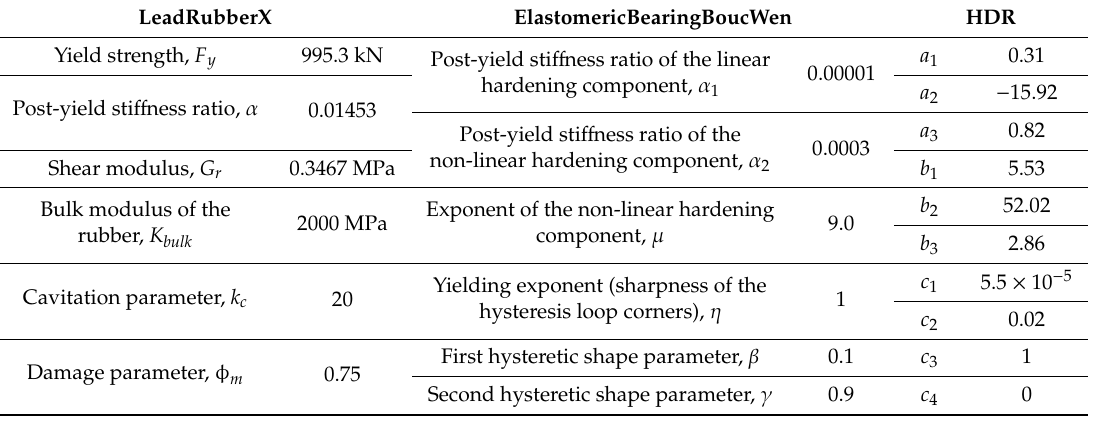
Table 2. Final calibrated parameters for the (lead rubber bearings) LRB model.